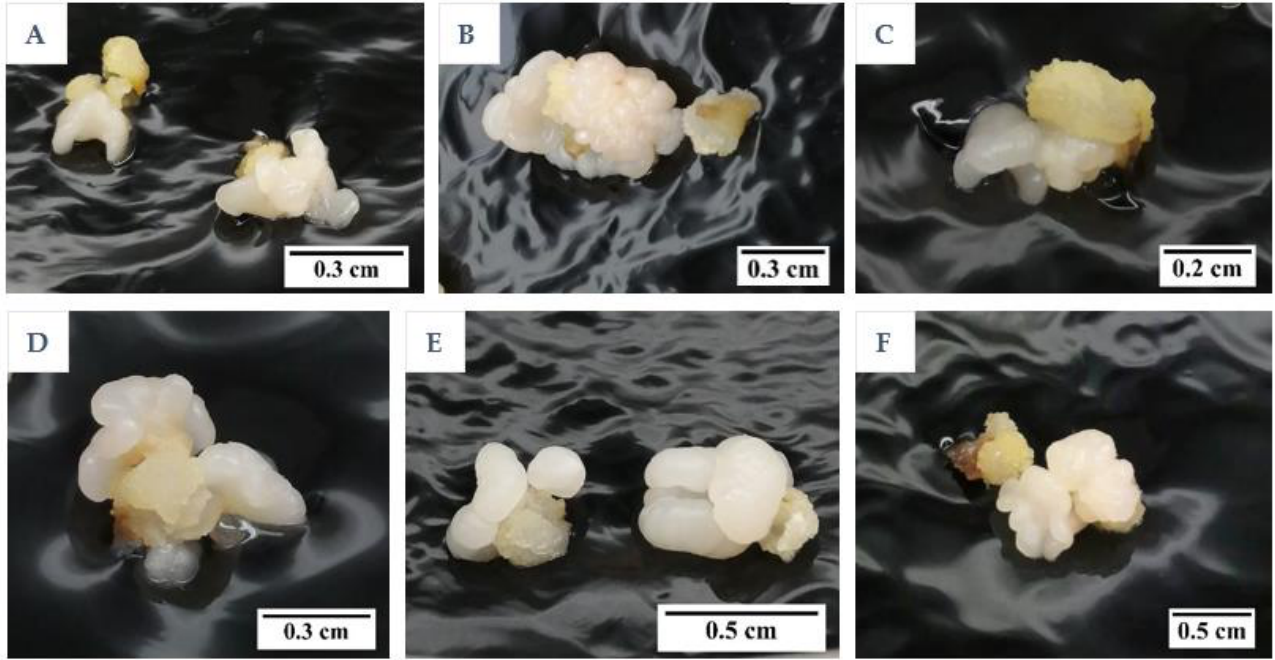
Figure 5. The formation of compact embryogenic callus for ( A ) control and treatments ( B ) T1, ( C ) T2, ( D ) T3, ( E ) T4, and ( F ) T5 (Control, T1 to T5; see table in Section 4.6) after 3 months.